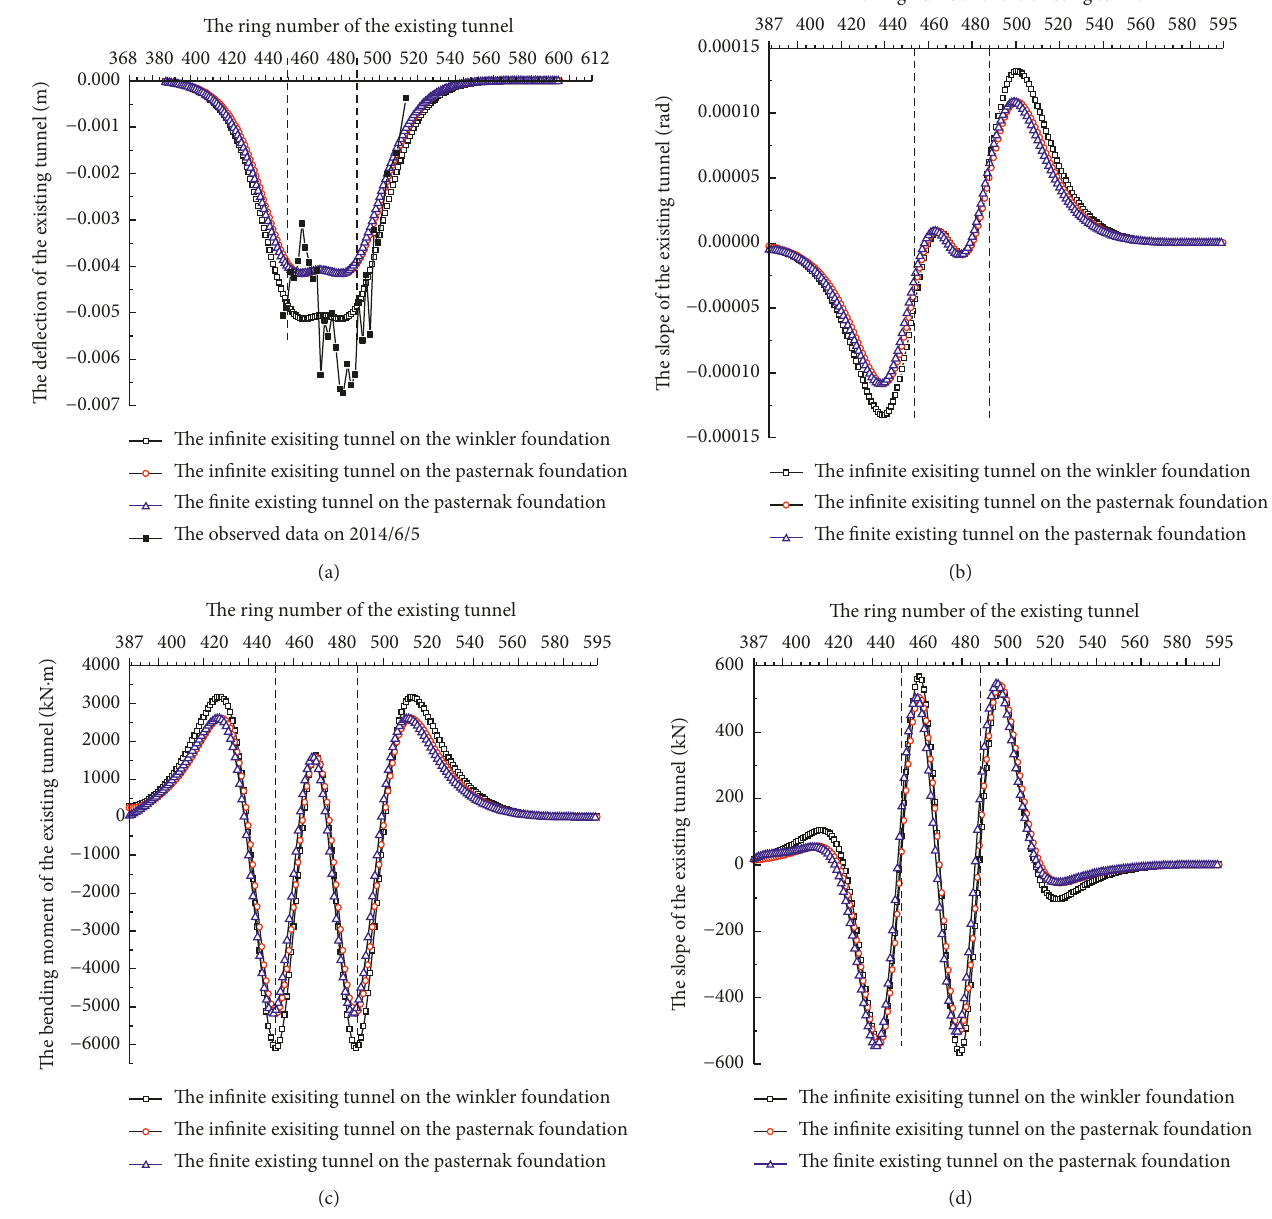
Figure 19: (a) Comparison of the deflection of the existing tunnel using different models. (b) Comparison of the rotational angle of the existing tunnel using different models. (c) Comparison of the normalized bending moment of the existing tunnel using different models. (d) Comparison of the normalized shear force of the existing tunnel using different